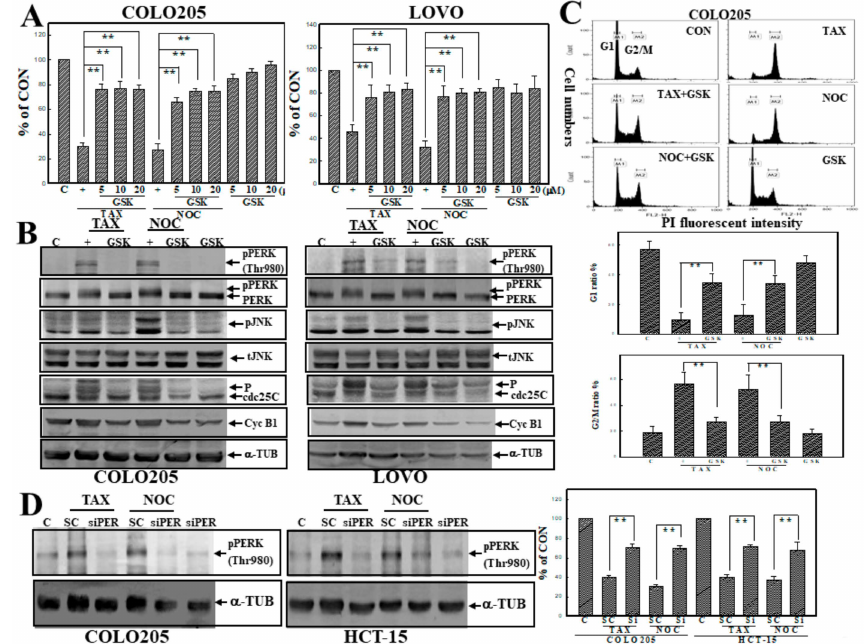
Figure 6. The PERK inhibitor GSK2606414 (GSK) inhibited cell death, PERK, and JNK protein phosphorylation in human CRC cells by TAX and NOC. ( A ) Both COLO205 and LOVO cells were treated with di ff erent concentrations (5, 10, and 20 µ M) of GSK for 30 min, followed by TAX and NOC (10 µ M) treatment for 24 h. The viability of cells under di ff erent treatments was examined by an MTT assay, and results are expressed as a percentage of the control (% of CON). ( B ) GSK inhibition of TAX- and NOC-induced cyclin B1, phosphorylated PERK, JNK, and Cdc25C protein expressions in COLO205 and LOVO cells. Both cell lines were treated with GSK (10 µ M) for 30 min, followed by TAX and NOC (10 µ M) stimulation for 12 h for detecting phosphorylated PERK and JNK proteins, cyclin B1, and phosphorylated Cdc25C proteins by Western blotting. ( C ) GSK reversed the increase in G 2 / M and the decrease in the G 1 ratio by TAX and NOC in COLO205 cells. ( D ) Knockdown of PERK protein by transfection of COLO205 and HT-29 cells with PERK siRNA (Si; siPERK) inhibited TAX and NOC-induced cell death. Both cells were transfected with siPERK or scramble siRNA (SC) (1 ng), and expression of phosphorylated PERK protein and viability of both cells were examined by Western blotting (left panel) and MTT assay (right panel), respectively. Each data point was calculated from three triplicate groups, and data are displayed as the mean ± SD. ** p < 0.01 denotes a significant di ff erence between the indicated